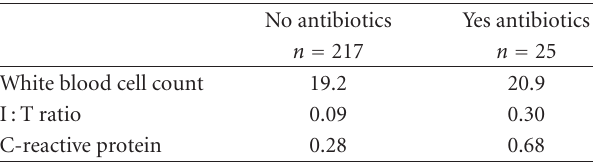
Table 2: Lab results for babies not treated with antibiotics after delivery and babies treated with antibiotics after